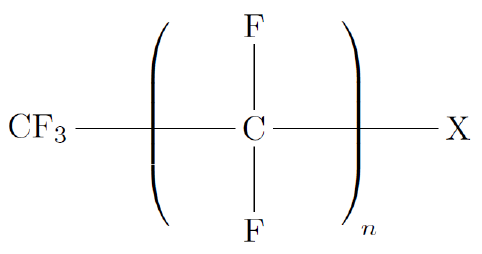
Figure 1. General structure of PFCs.